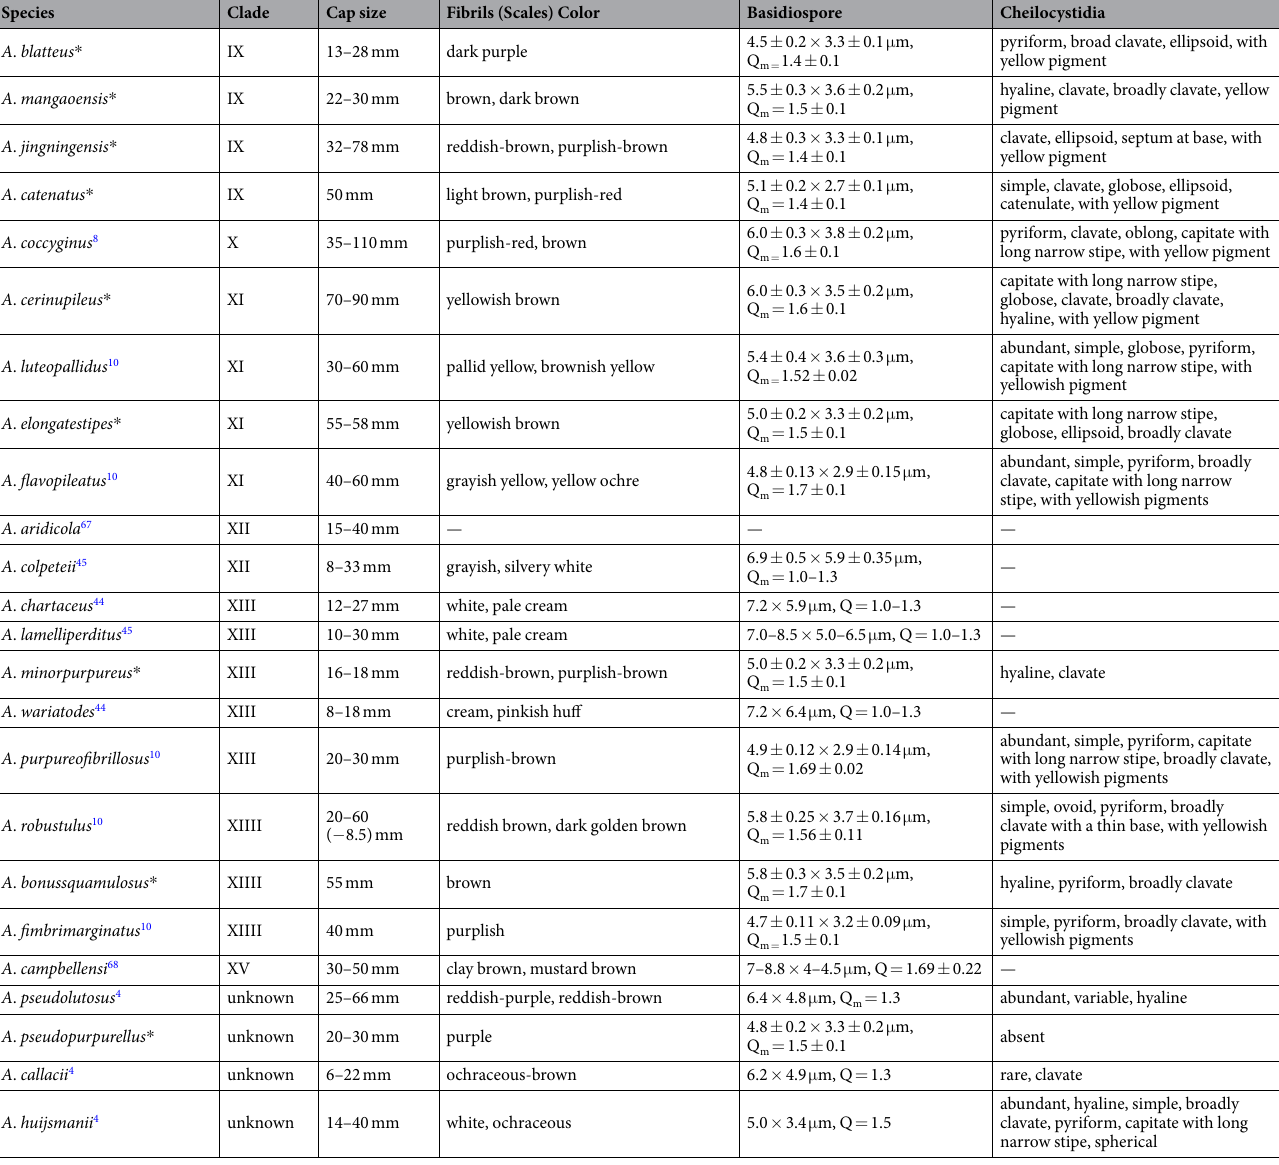
Table 2. Main morphological features of species in Agaricus sect. Minores , * means new species described in this